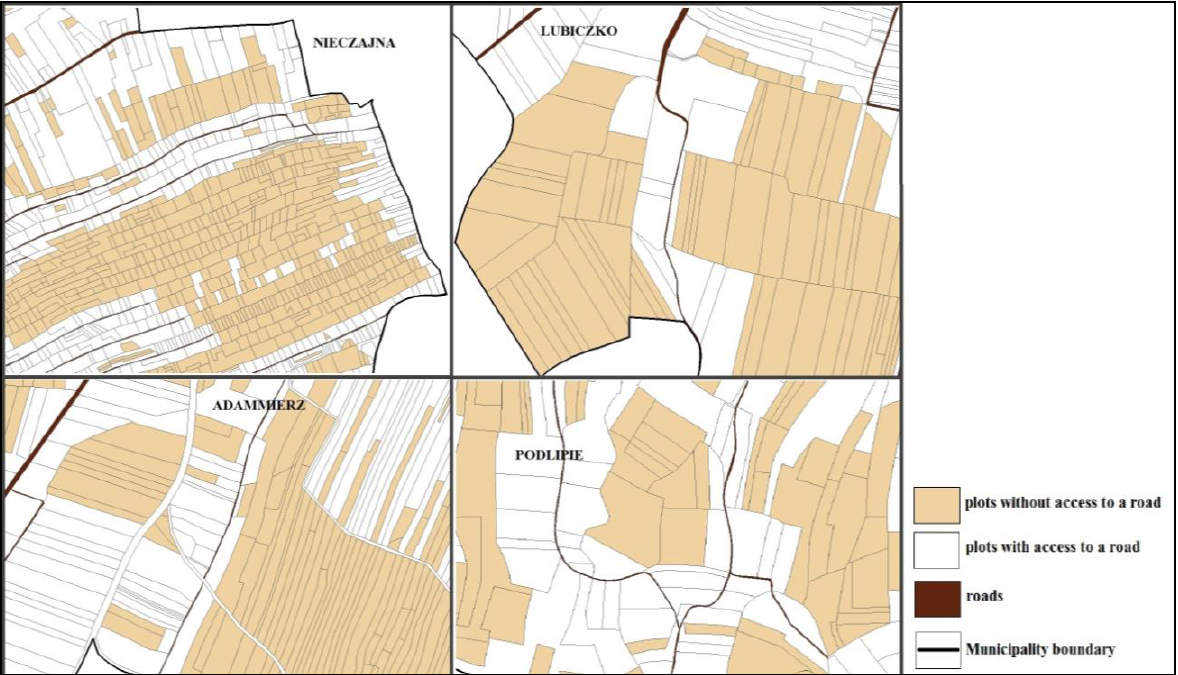
Fig. 3. Visualisation of plots without access to a public road (in beige) in selected villages in Małopolska (source: own